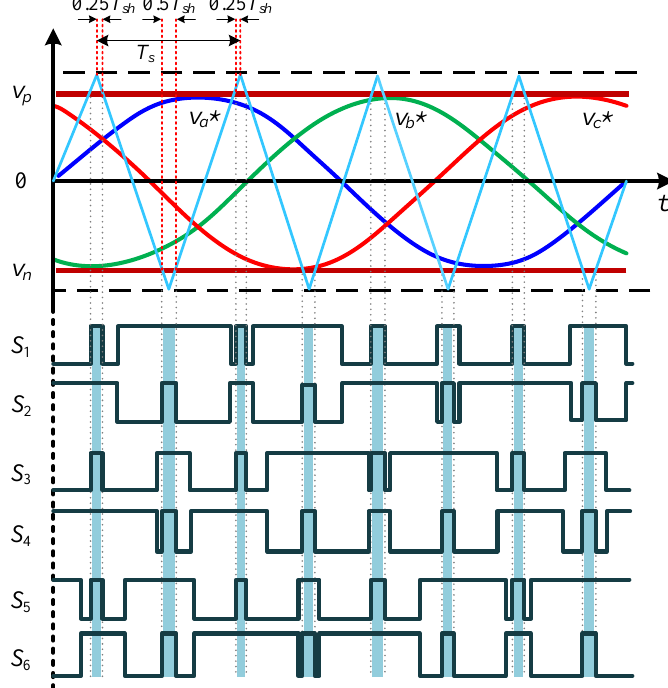
Figure 2. Three-phase simple boost pulse width modulation (PWM)